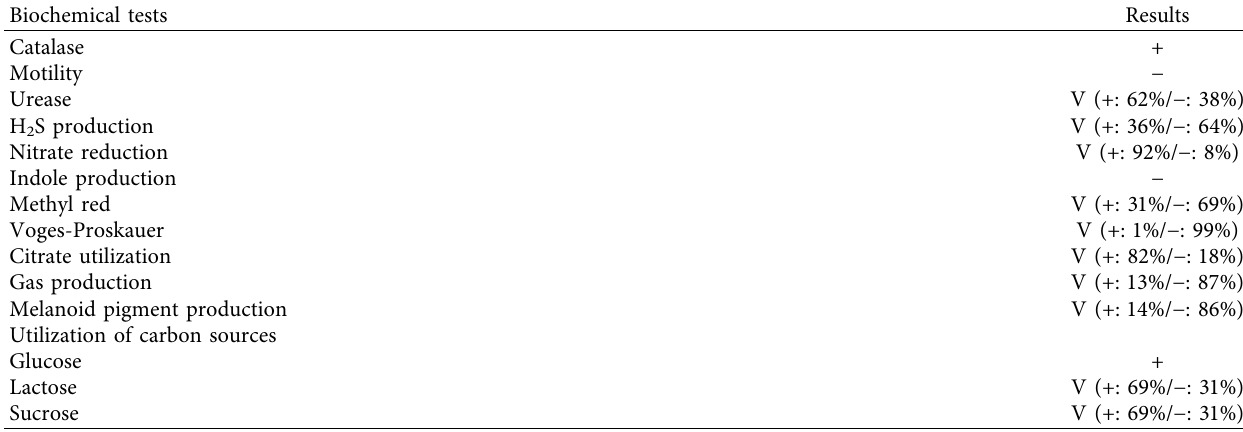
Table 2: Biochemical characteristics of the Streptomyces isolates.